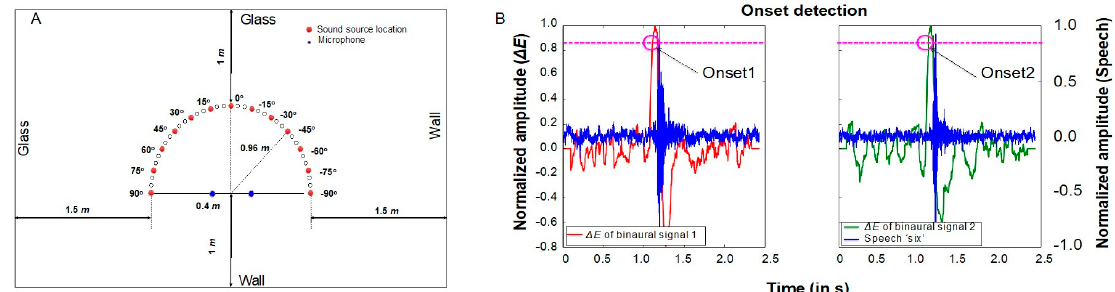
Figure 7. ( A ) Experiment setup in a reverberant environment (an office); ( B ) Onset detection; the log-energy change ∆ E of the spoken digit ‘six’ (blue) is shown in red and green, and the circles mark the detected onset time for each input of the binaural signal. The first onset time t is selected to be the onset time. Adapted from Reference